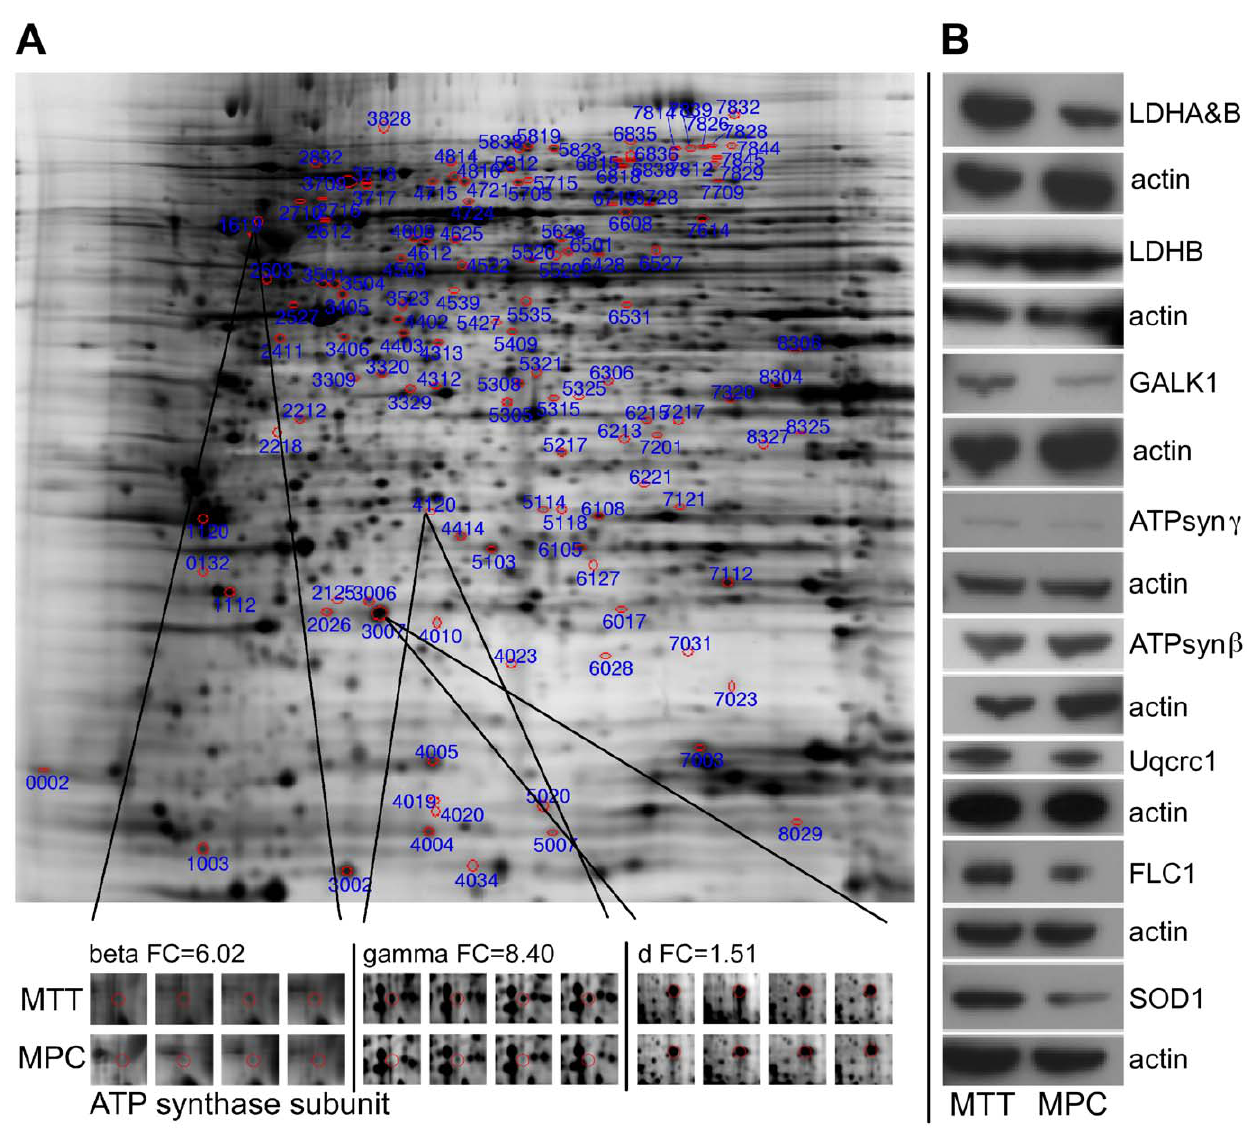
Figure 1. Protein expression in MPC compared to MTT. A Representative silver staining of 2D-gel. Spots of interest are circled in red. Magnification of spots containing ATP synthase subunits are shown below for all four MPC and MTT gels. B Western blot for validation of differential expression of selected proteins of interest.